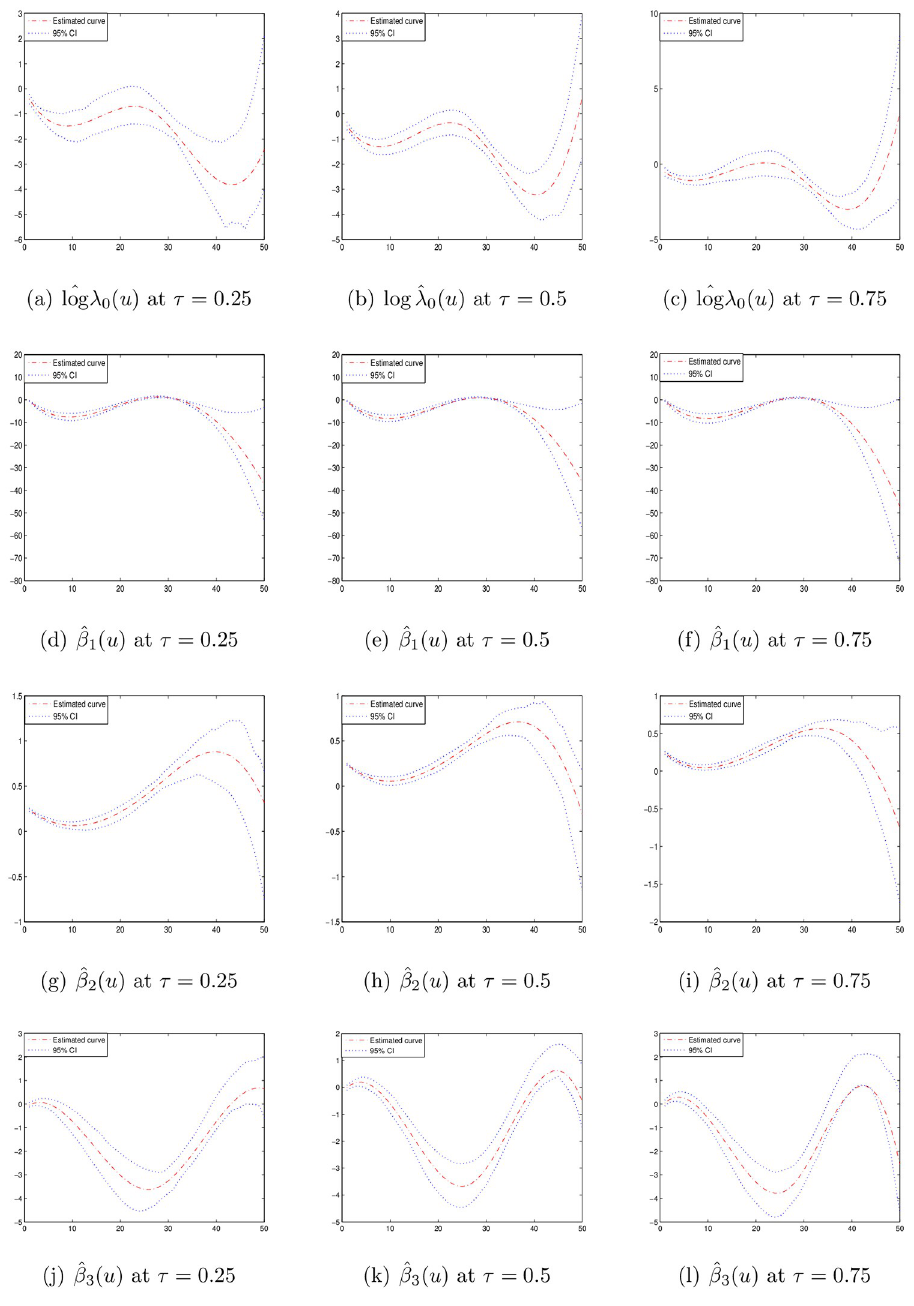
Fig 4. Estimated curves of time-varying functions for bladder cancer data at different τ